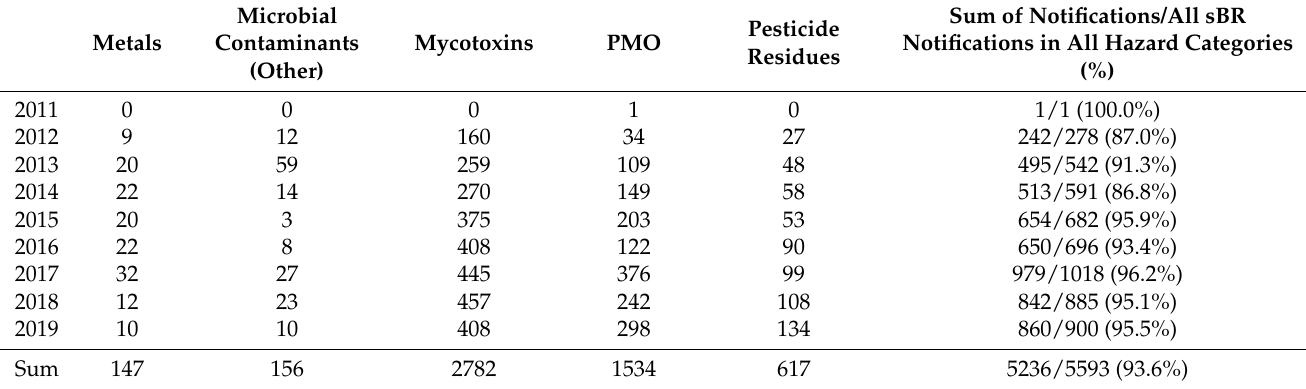
Table 6. Yearly distribution of serious border rejection (sBR) notifications in five hazard categories (mycotoxins, microbial contaminants (other), pesticide residues, metals, pathogenic microorganisms (PMO)), and their sum as a percent share (%) of all sBR notifications in all hazard categories in the EU RASFF (2011–2019). Numbers of sBR Notifications on Food in Five Hazard Categories and Percent Share of Each One over All Year